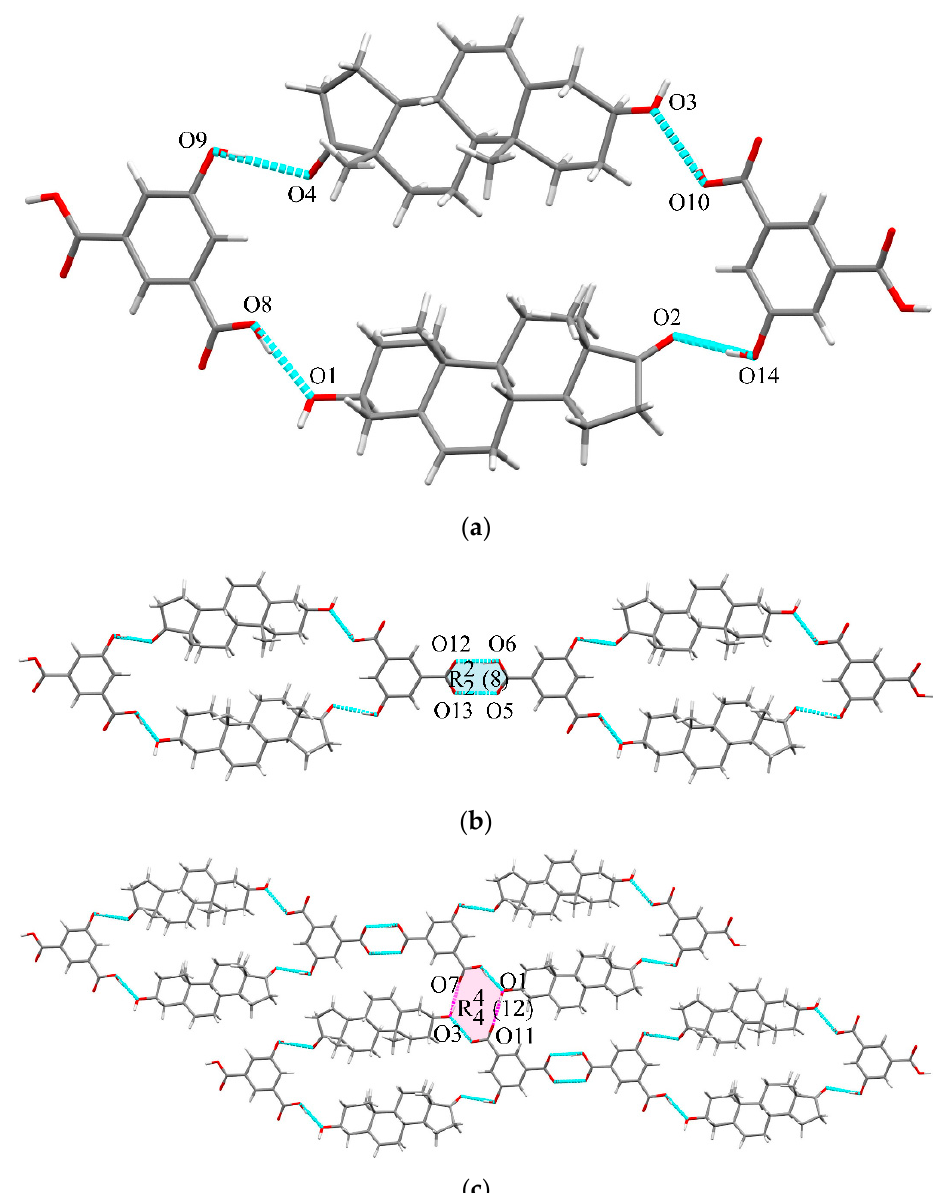
Figure 8. ( a ) tetramer, ( b ) 1D, and ( c ) 2D supramolecular interactions of DHEA-5HIPA.